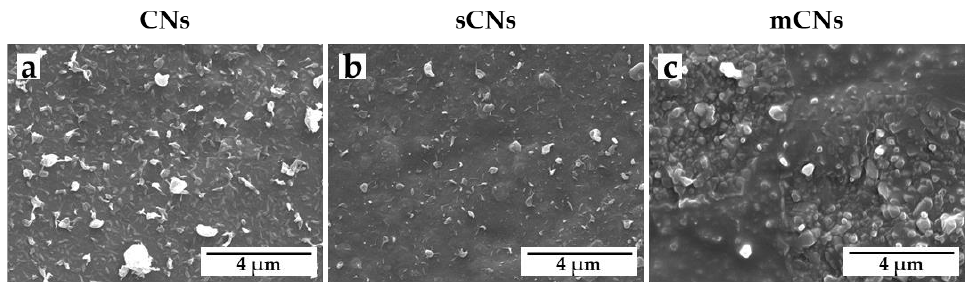
Figure 1. SEM micrographs of electrosprayed CNs from different sources: ( a ) CNs (from crustaceans by Texol s.r.l.); ( b ) sCNs (from shrimps, by Celabor s.c.r.l.); and ( c ) mCNs (from mushroom by Celabor s.c.r.l.). Scale bar: 4 µ m, high voltage (HV) 10 kV, magnification 30,000 × .